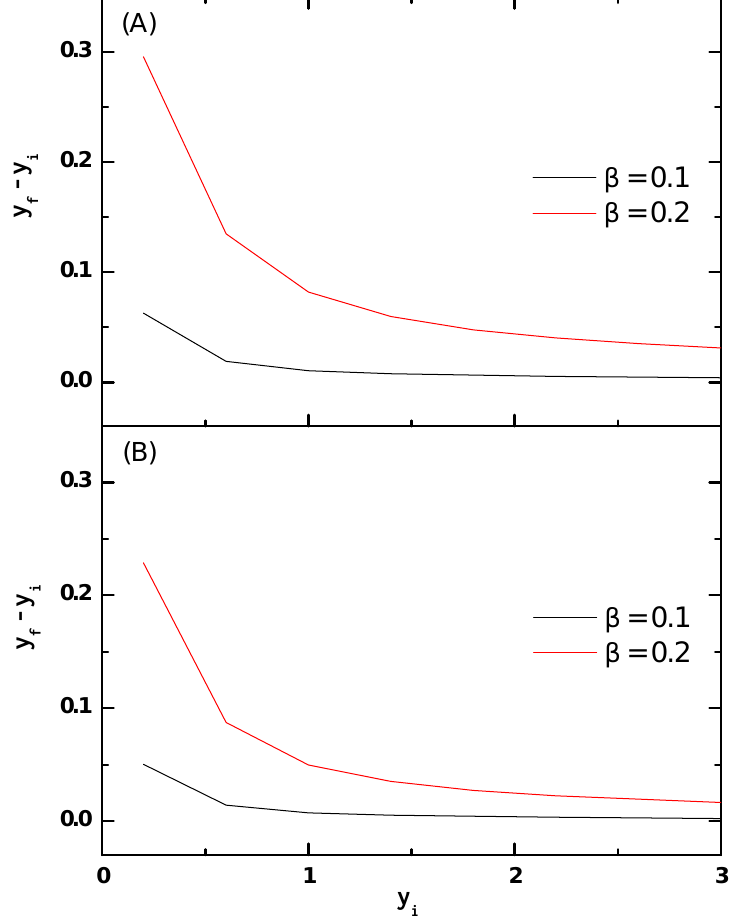
Figure 5. Deviation y f − y i versus y i at N = 50 for two cases: ( A ) low frequency and Λ = 1; ( B ) low frequency and Λ =